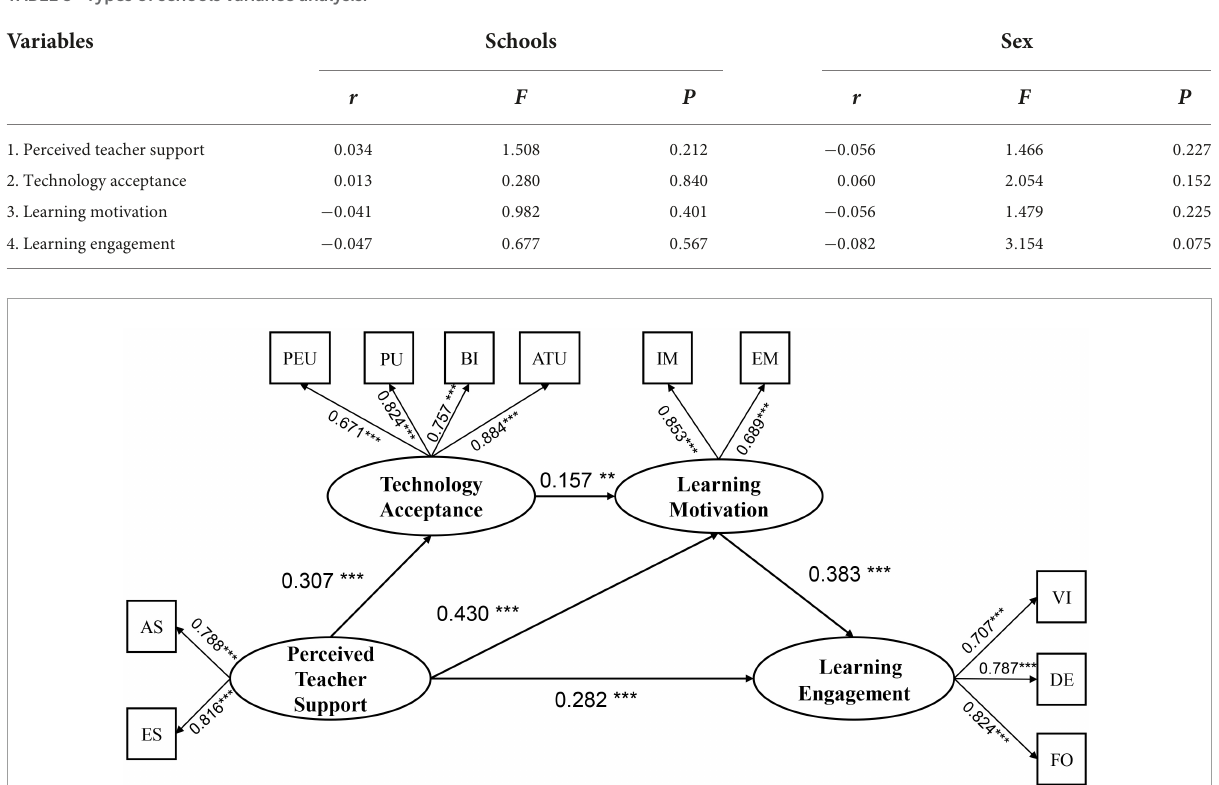
TABLE 3 Types of schools variance analysis.